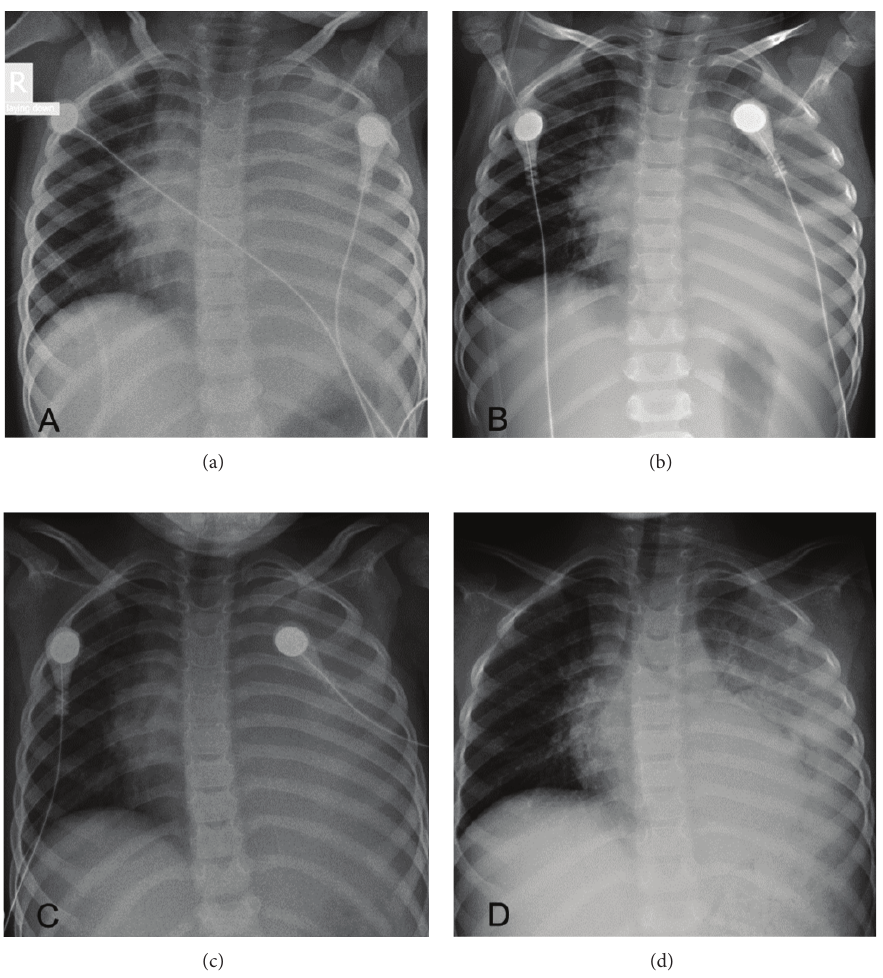
Figure 1: A 5-year-old patient with severe expanding pneumococcal pneumonia. (a) Note “white hemithorax” on the left with increased volume causing mediastinal shift to the right. (b) After a single course of left IV methylprednisolone. Significant improvement in the aeration of the left lung with residual consolidation above the diaphragm. (c) A clinical and radiologic deterioration. (d) Improved aeration of the left lung after a second course of IV